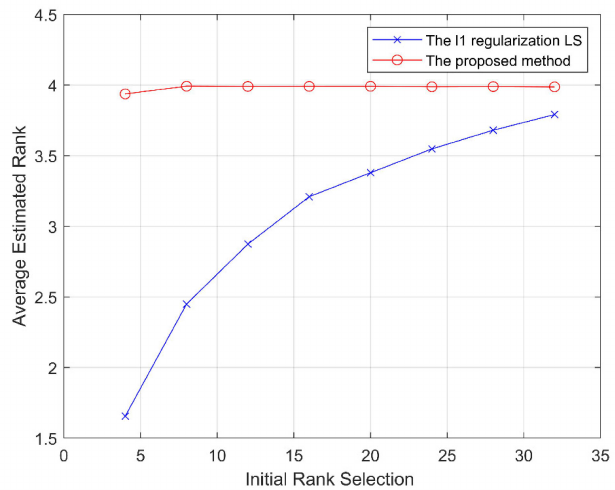
Figure 4. Robustness of the proposed method regrading different initial rank values with R = 4, SNR = 20 dB, λ = 10 − 4 and γ = 0.3.